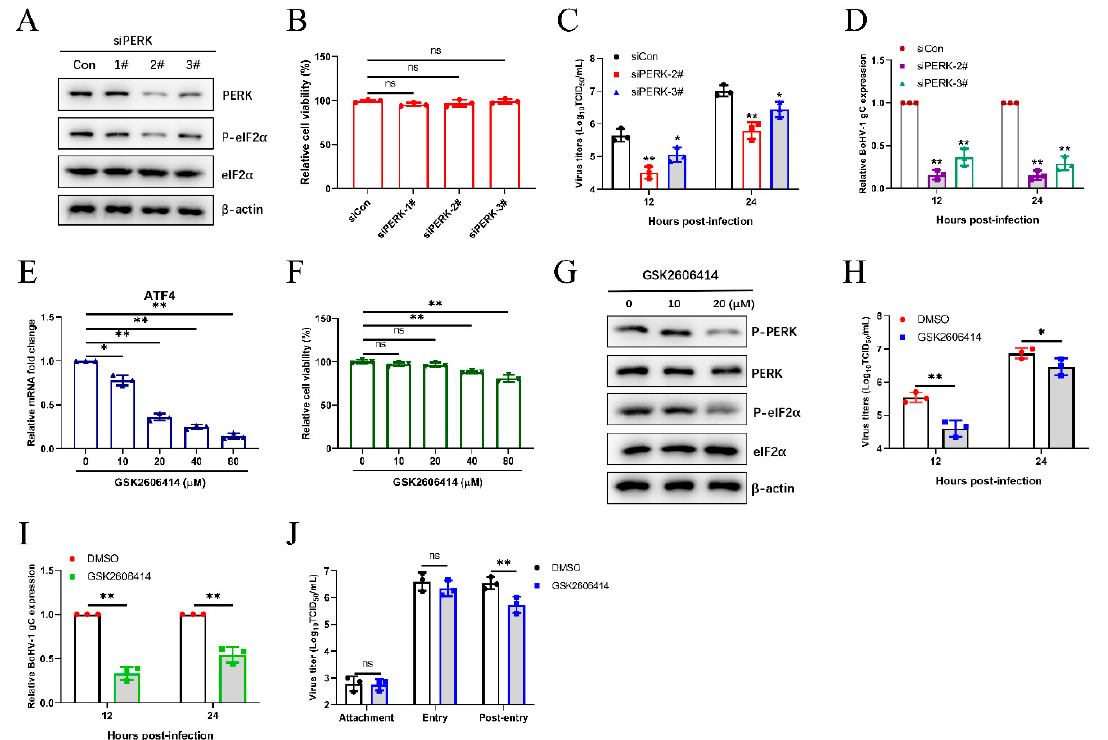
Figure 4. The BoHV1-activated PERK pathway facilitates viral proliferation. ( A ) MDBK cells were transfected with siRNAs targeting PERK for 48 h, and then cells were infected with BoHV-1. Immunoblot analysis of the silencing efficiency of PERK at 24 hpi. ( B ) The CCK-8 assays were performed to analyze the MDBK cell viability. ( C , D ) At 48 h post siRNA transfection, MDBK cells were infected with BoHV-1 (0.1 MOI). The viral titers of BoHV-1 and the relative expression of BoHV-1 gC were detected at the indicated time points. ( E ) The efficiency of GSK2606414 in inhibiting the PERK pathway was evaluated by detecting the ATF4 mRNA levels in MDBK cells. ( F ) The cytotoxicity of GSK2606414 was measured using a CCK-8 assay. ( G ) Immunoblot analysis of total PERK, total eIF2 α , phosphorylated PERK, and phosphorylated eIF2 α in MDBK cells treated with different concentrations of GSK2606414. ( H , I ) The viral titers and gene expression of BoHV-1 in MDBK cells treated with GSK2606414 (20 μ M) or DMSO at 12 and 24 hpi were determined. ( J ) Effect of PERK inhibition on BoHV-1 replication stages. MDBK cells infected with BoHV-1 (0.1 MOI) were treated with GSK2606414 (20 μ M) at the virus binding, virus entry, or post-entry process, respectively. The viral titers were determined in MDBK cells. The mean ± SD of data from three independent experiments are shown; * p < 0.05, ** p < 0.01.